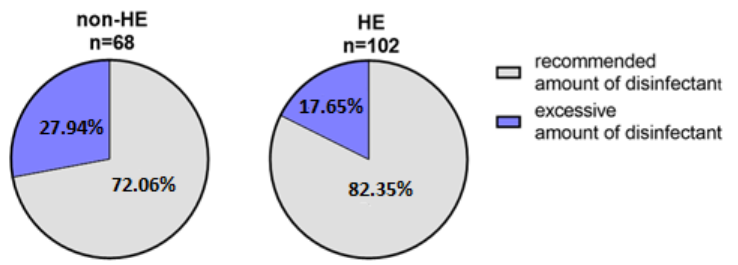
Figure 18. Amount of disinfectant applied by respondents.